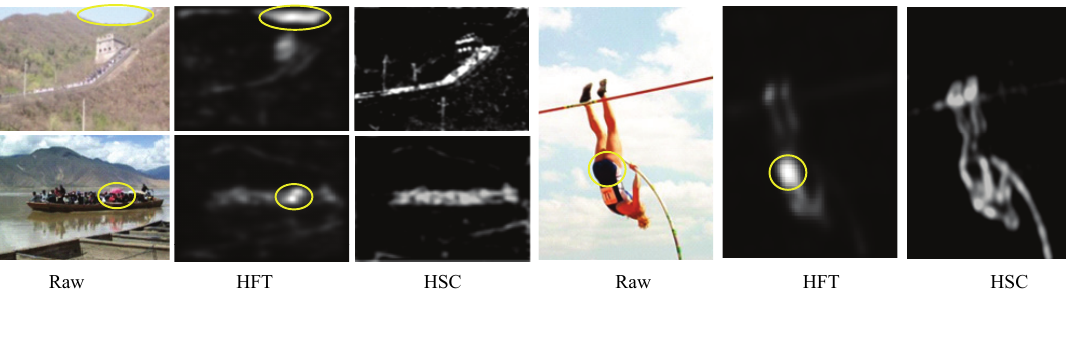
Figure 9. The results of saliency maps using HFT and